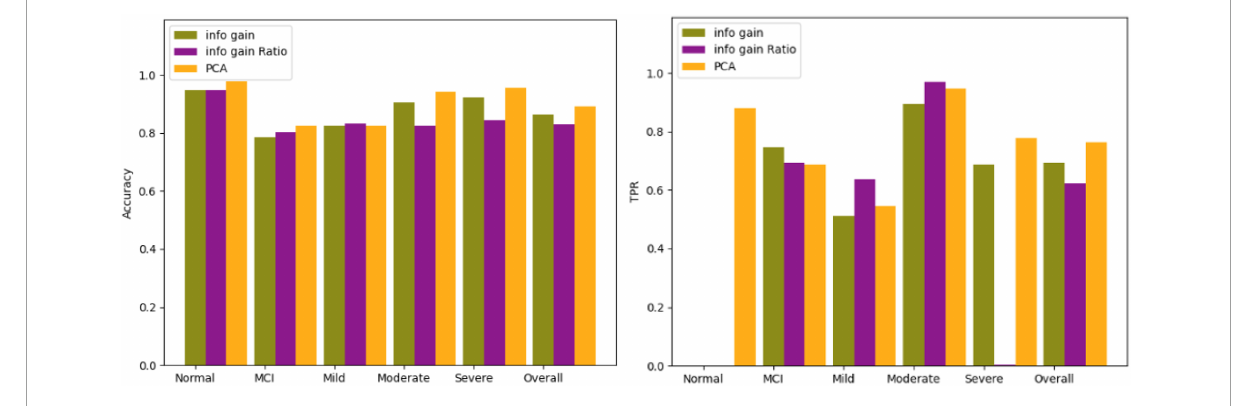
FIGURE6 Comparison results for 14 questions.